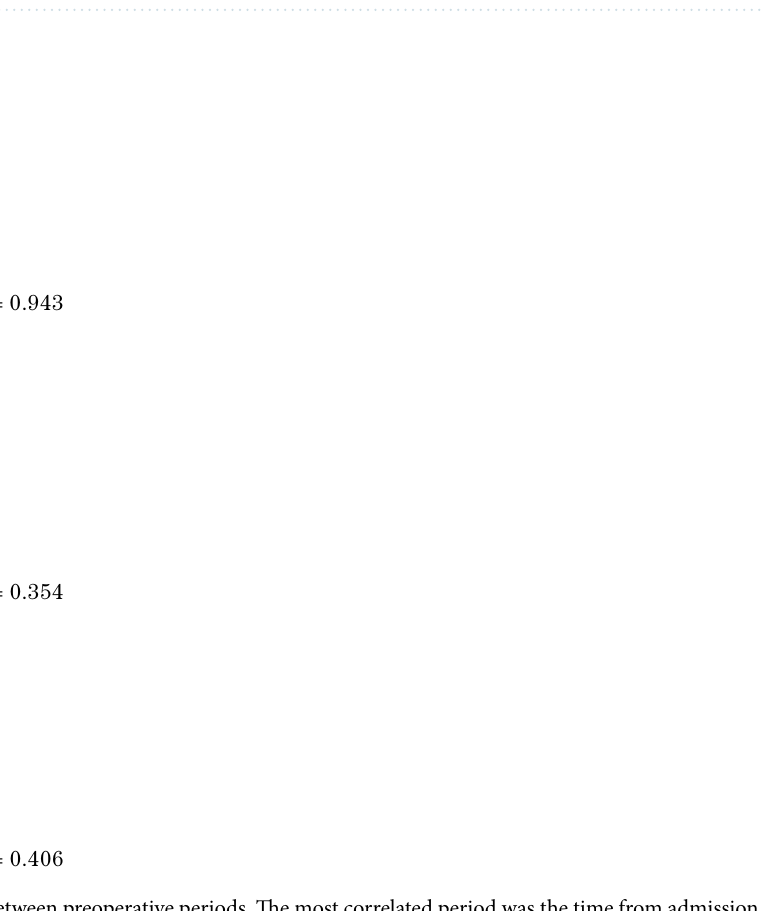
Table 4. Preoperative period. After the introduction of the Tokyo Guidelines, the time from onset to surgery was shortened (p = 0.017) as compared with that before. But the time from admission to surgery did not change so much in each group.